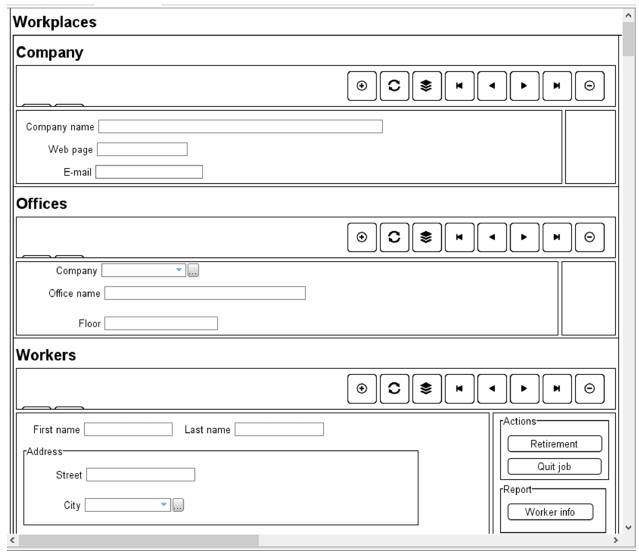
Figure 11. An example of a parent-child